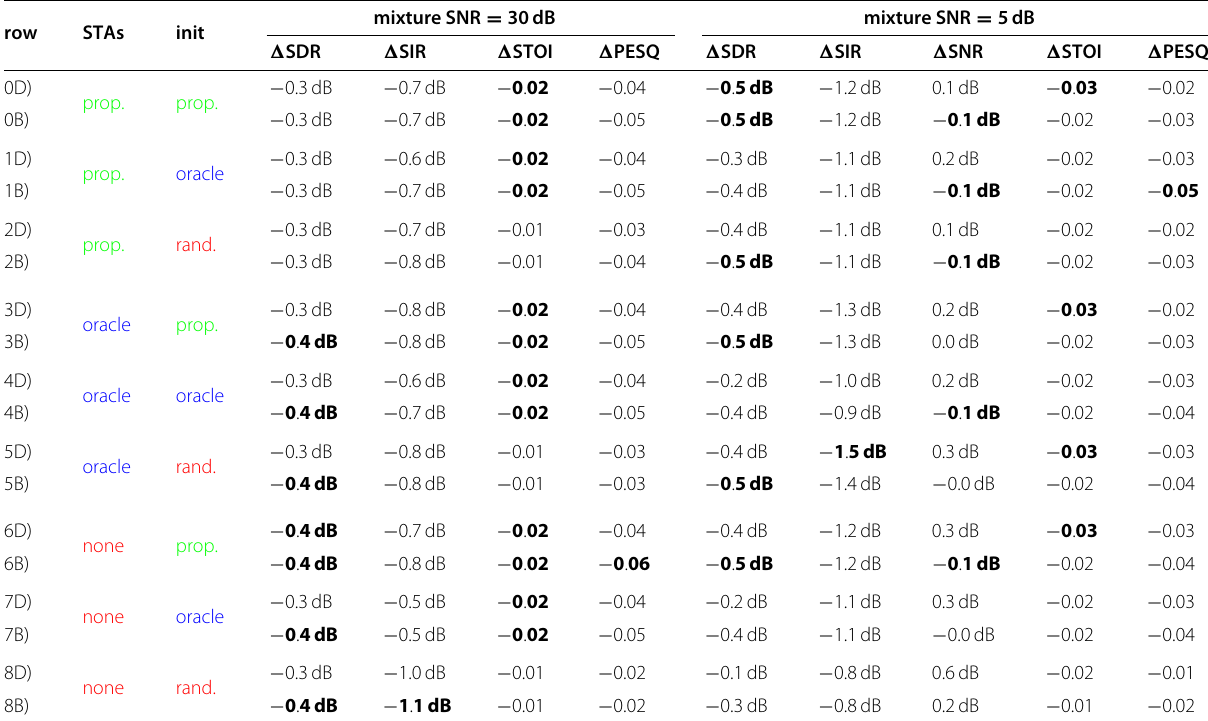
Table 3 Results with estimated DOAs in terms of the difference compared to the oracle DOA results displayed in Table 2. Here, the numbers printed in bold indicate when there is the most significant deterioration. Because K = D + 1 direction-based components are used, DOA errors here have an impact on the results regardless of the choice of STAs and initialization. On the other hand, based on the minor differences between the rows, we conclude that the incorporation of DOA-based a priori knowledge is quite robust to DOA errors